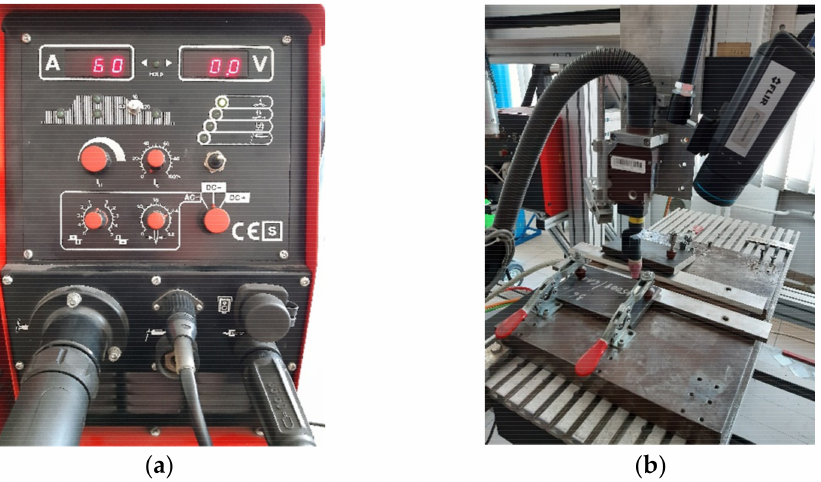
Figure 1. The welding device ( a ) and tungsten inert gas (TIG) torch ( b ) used during the